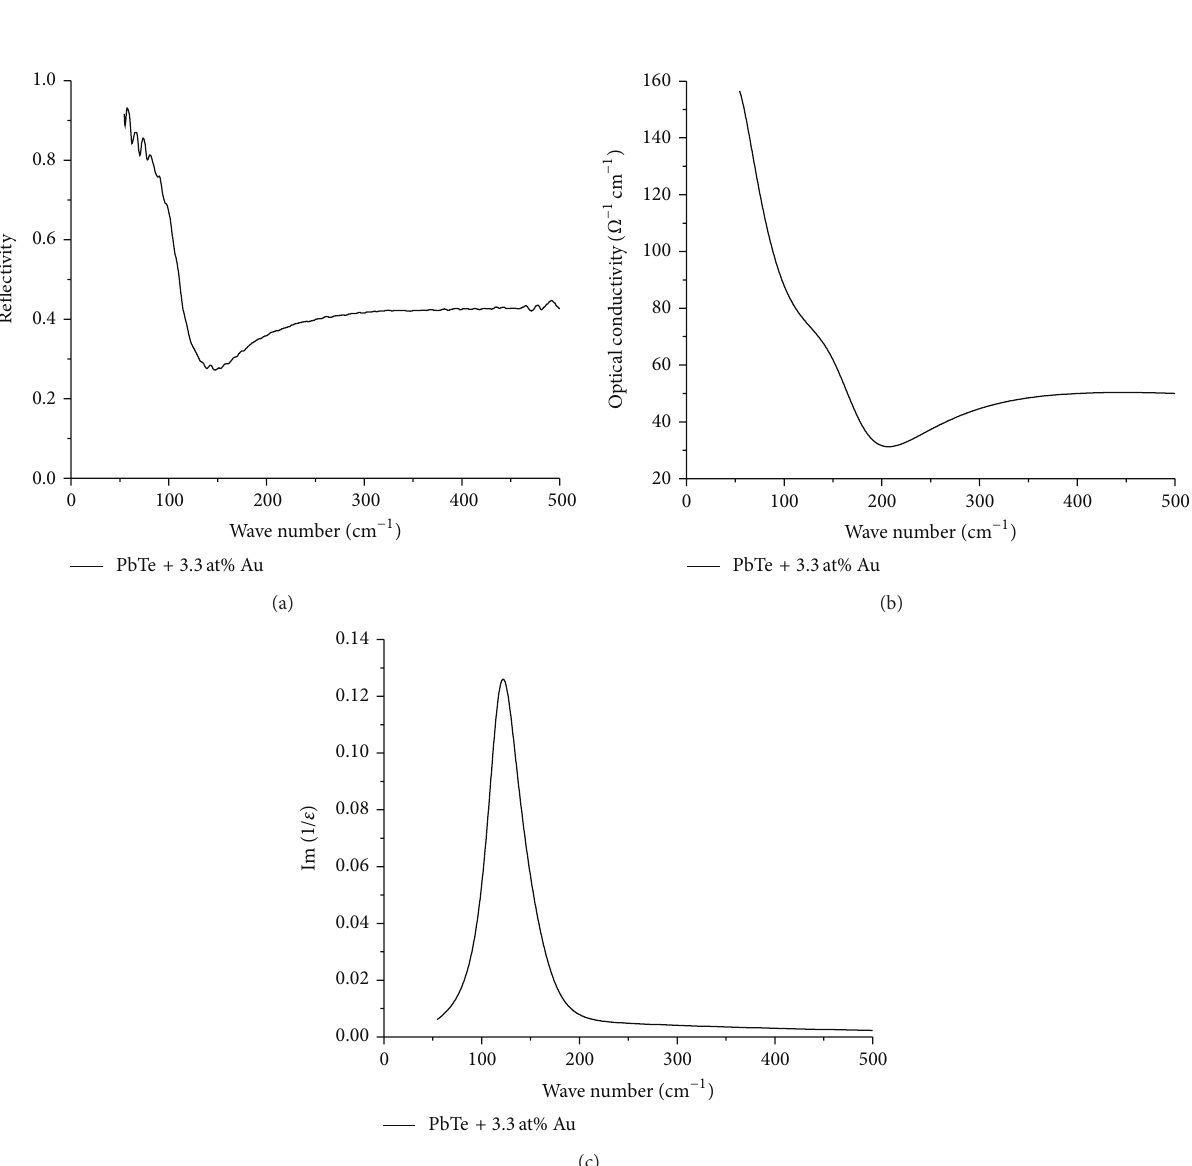
Figure 7: (a) Optical reflectivity diagram for PbTe doped with 3.3 at% Au, (b) its optical conductivity, and (c) reciprocal value of imaginary part of dielectric constant [Im (1/𝜀)